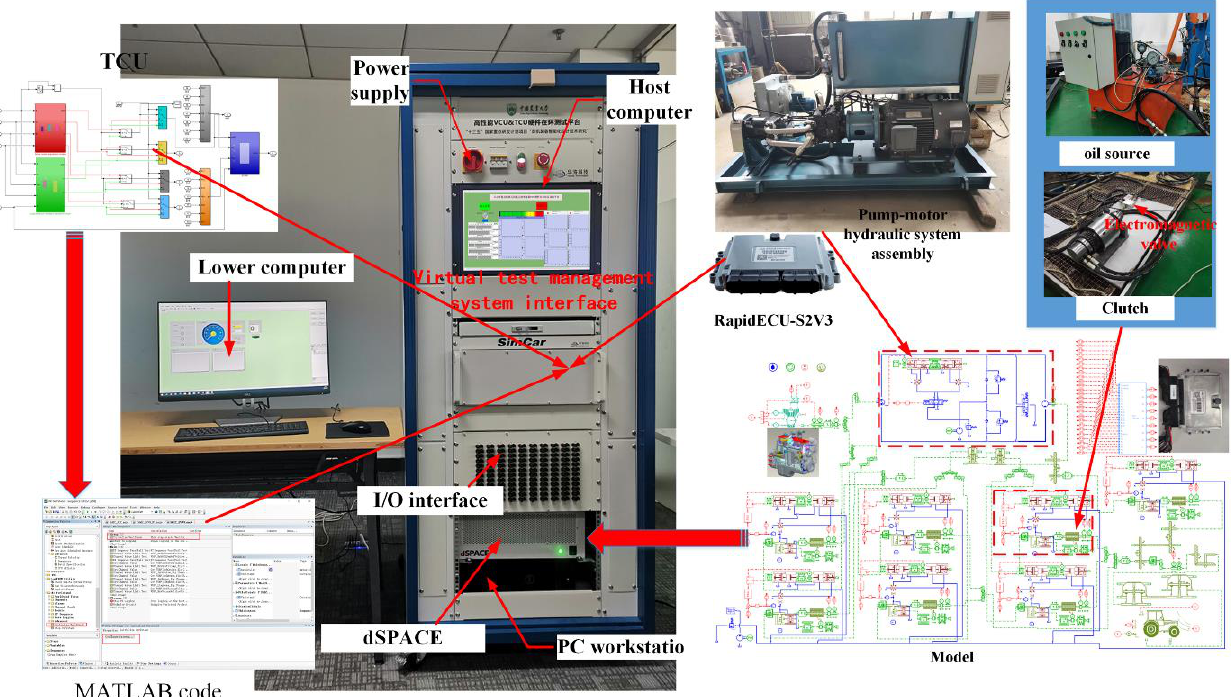
Figure 12. HMCVT hardware in the loop test platform.